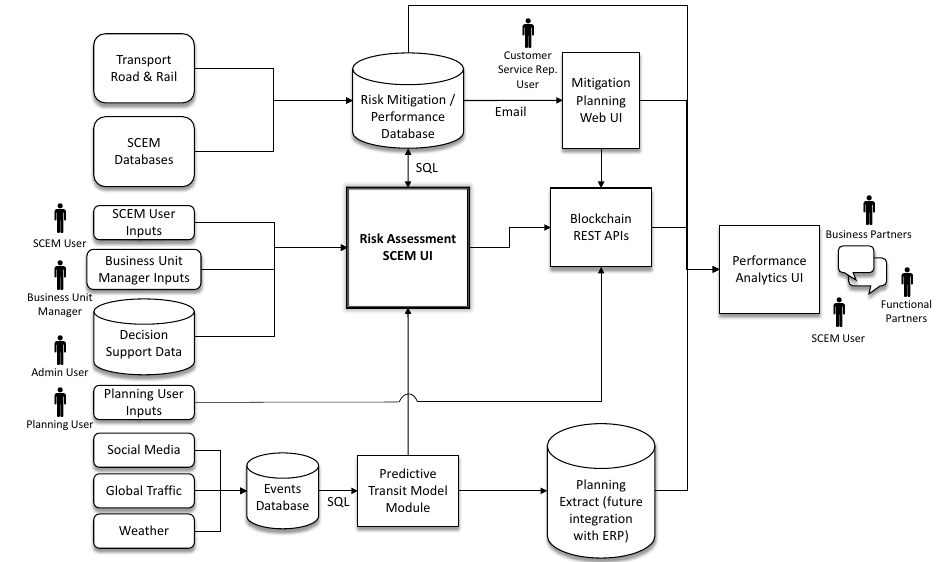
Figure 4. Relationships among the modules (adapted from [13]).